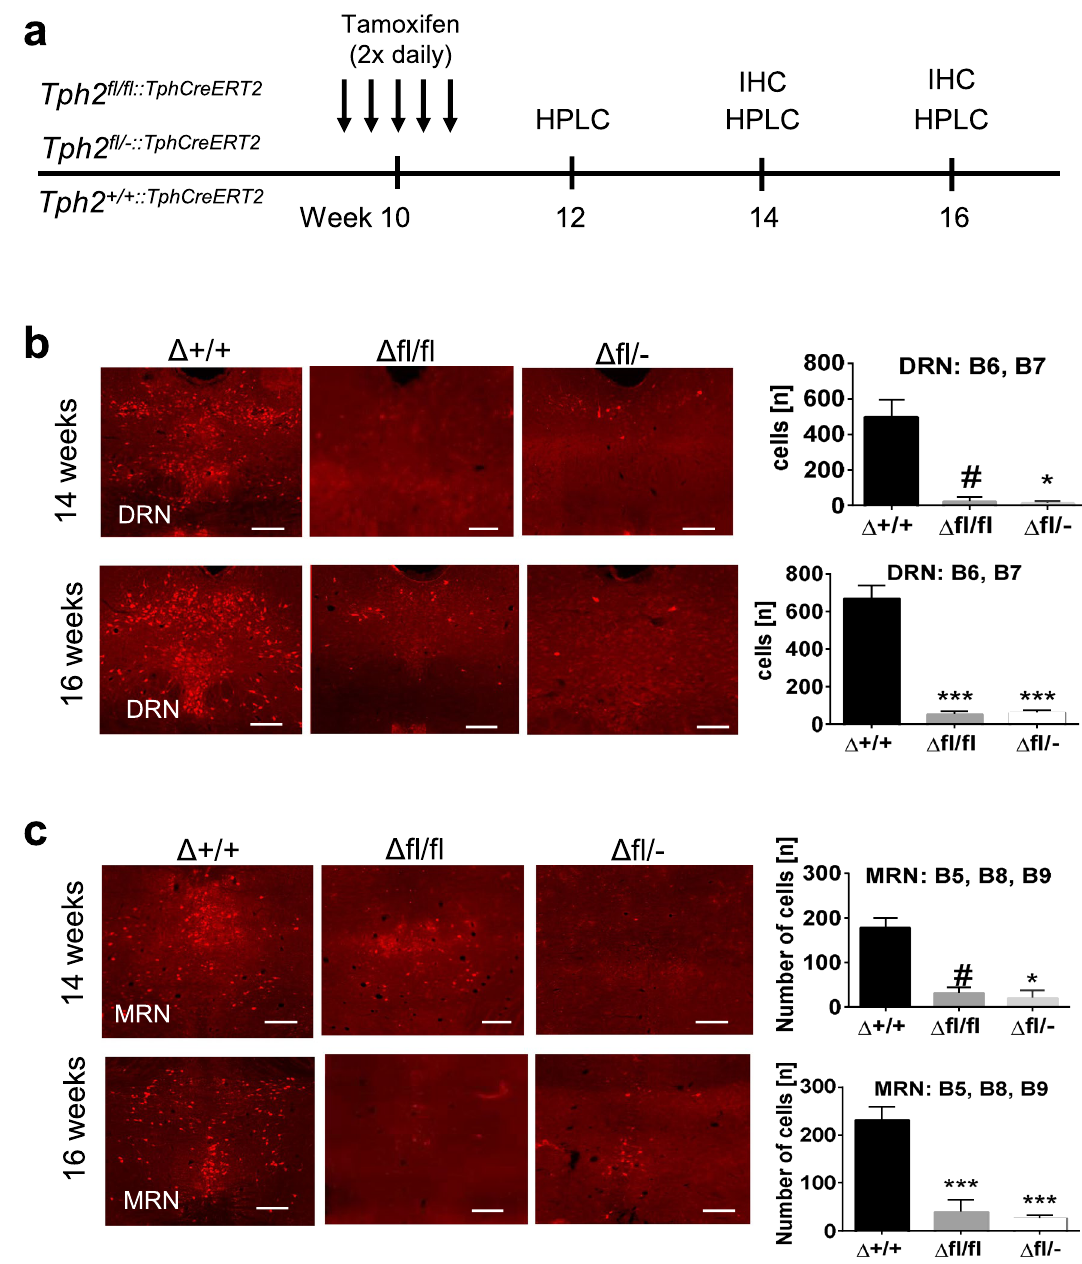
Figure 1. Tamoxifen (TAM)-induced Cre/fl-mediated inactivation of the tryptophan hydroxylase-2 ( Tph2 ) gene during adulthood in raphe 5-HT neurons of Tg Tph2creERT2 / Tph2 +/+ (Δ+/+), Tg Tph2creERT2 / Tph2 fl/fl (Δfl/fl) and Tg Tph2creERT2 / Tph2 fl/- (Δfl/−) mice. ( a ) Timeline for gene targeting, immunohistochemistry (IHC) and HPLC; ( b ) IHC and quantification of 5-HT positive cells in the dorsal raphe nucleus (DRN) B6 and B7 at week 14 (upper panel) and week 16 (lower panel) after treatment; ( c ) IHC and quantification of 5-HT positive cells in MRN at week 14 (upper panel) and week 16 (lower panel) after treatment. Number of 5-HT positive cells counted represented as mean ± SEM in week 14 (n = 4/group) and week 16 (n = 6–9). Data are shown as mean ± SEM. #0.05 < p < 0.1, * p < 0.05 and *** p <